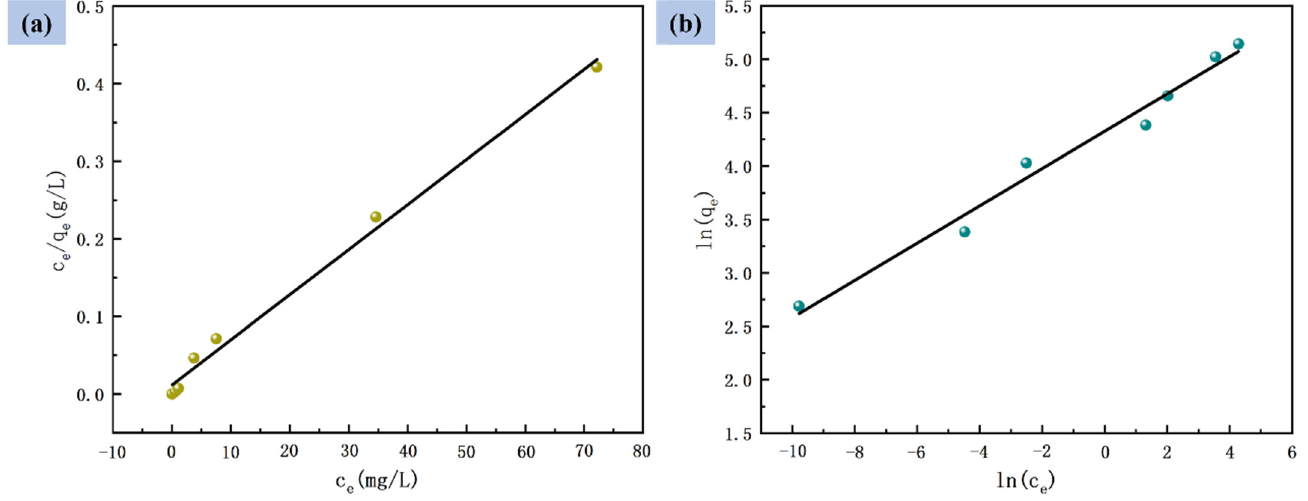
Figure 9. ( a ) Langmuir isotherm model and ( b ) Freundlich isotherm model for adsorption of Cr(VI). Table 2. Comparison of kinetic parameters between the Langmuir and Freundlich models of Cr(VI) adsorption with PVDF–2GO@GO ENFM.